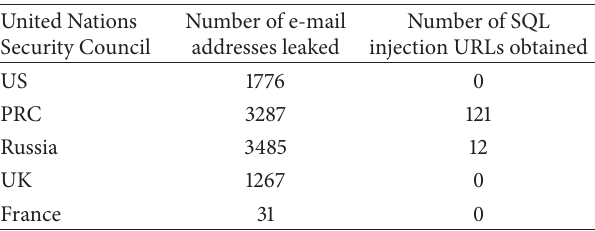
Table 2: Statistics of permanent membership of the United Nations Security